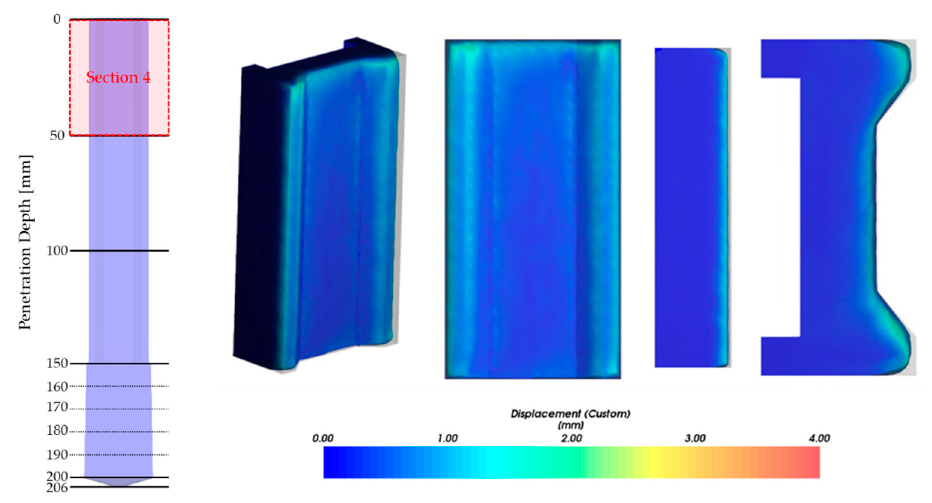
Figure 13. Worn displacement on Section 3.